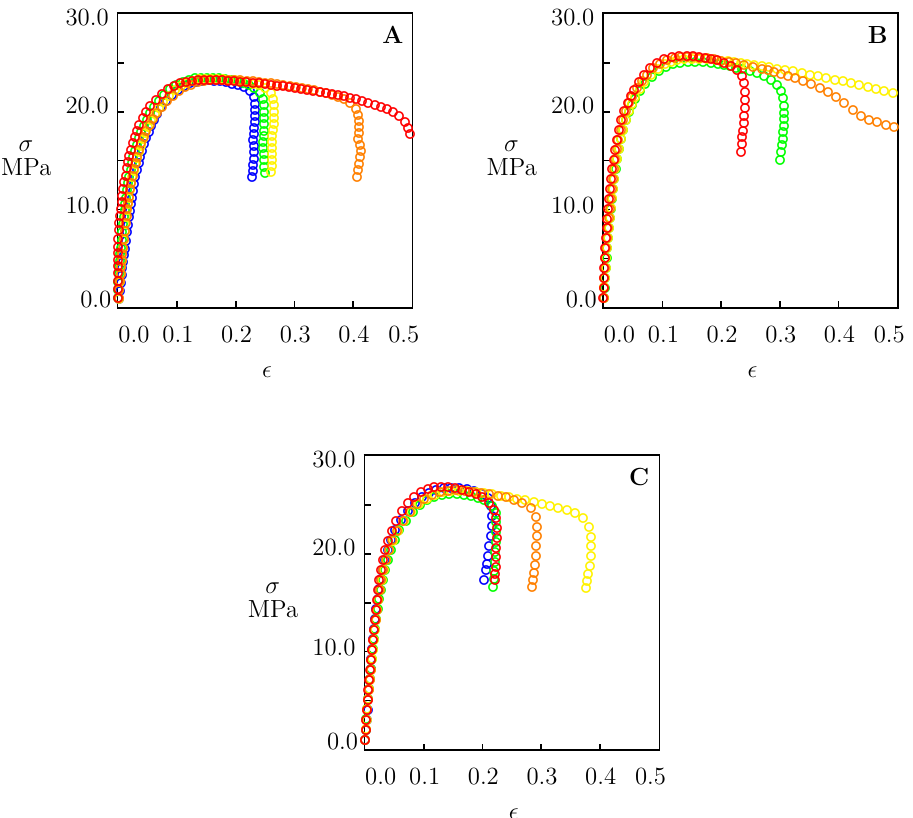
Figure 1. Tensile stress σ versus tensile strain (cid:101) . Circles: experimental data in tensile tests with cross-head speeds ( A ) 10, ( B ) 50, and ( C ) 100 Figure 1: Tensile stress σ versus tensile strain (cid:15) . Circles: experimental data in tensile tests with cross-head speeds 10 (A), 50 (B) and 100 (C) mm/min.